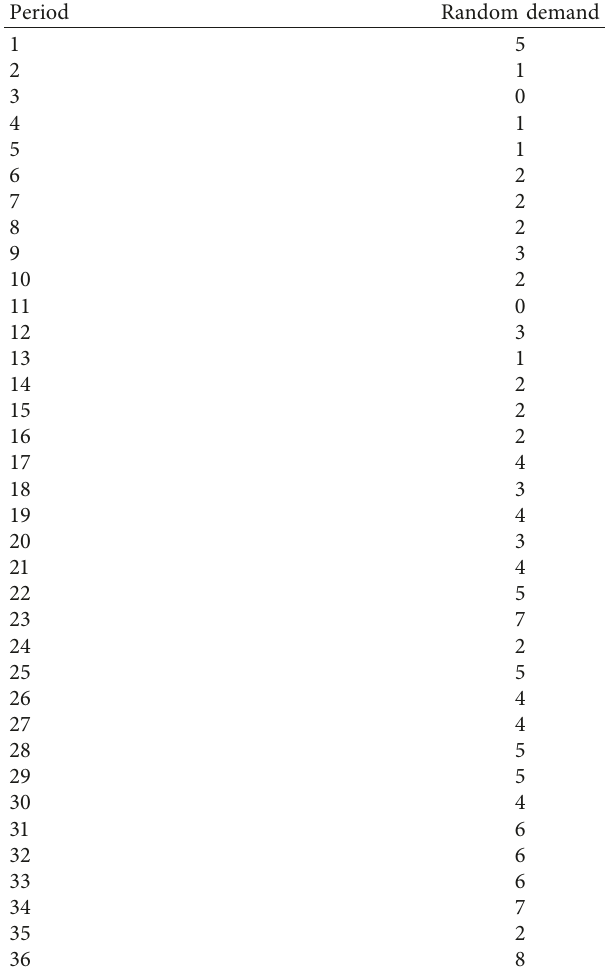
Table 3: Random demand data for